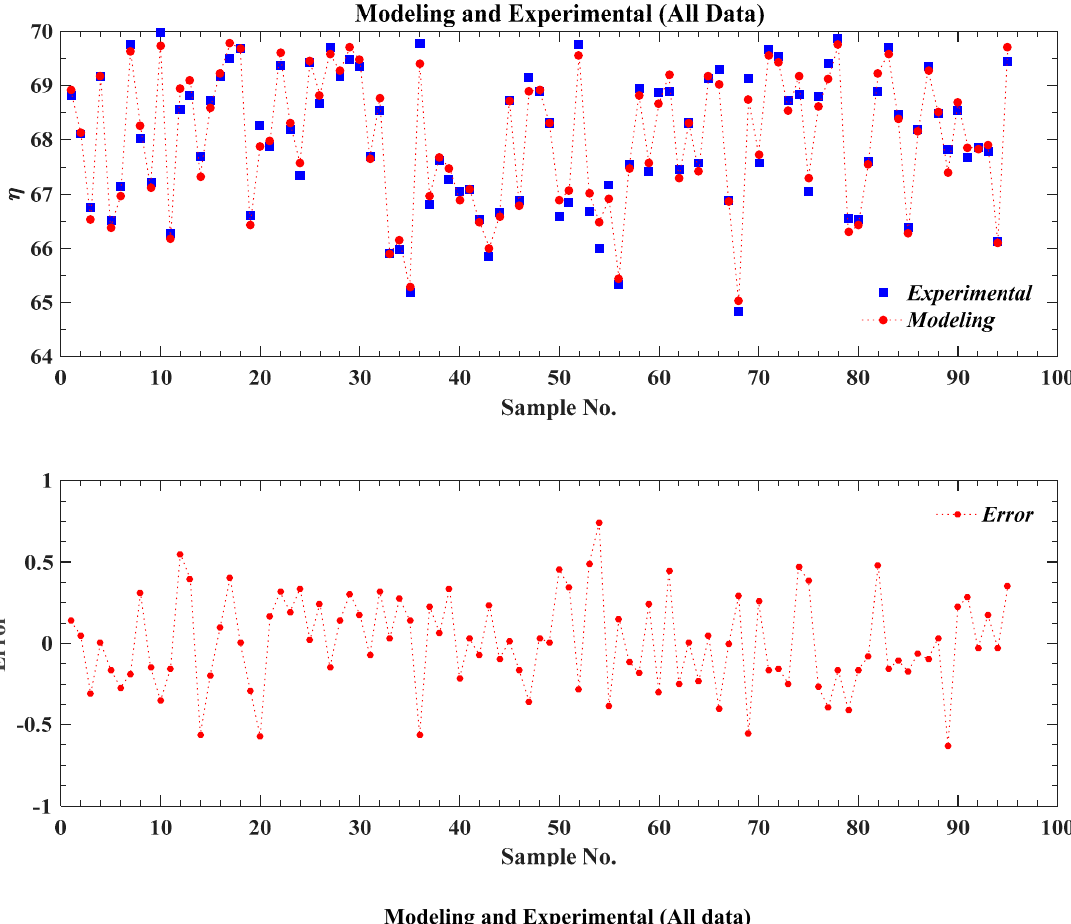
ffi ciency measurements (95